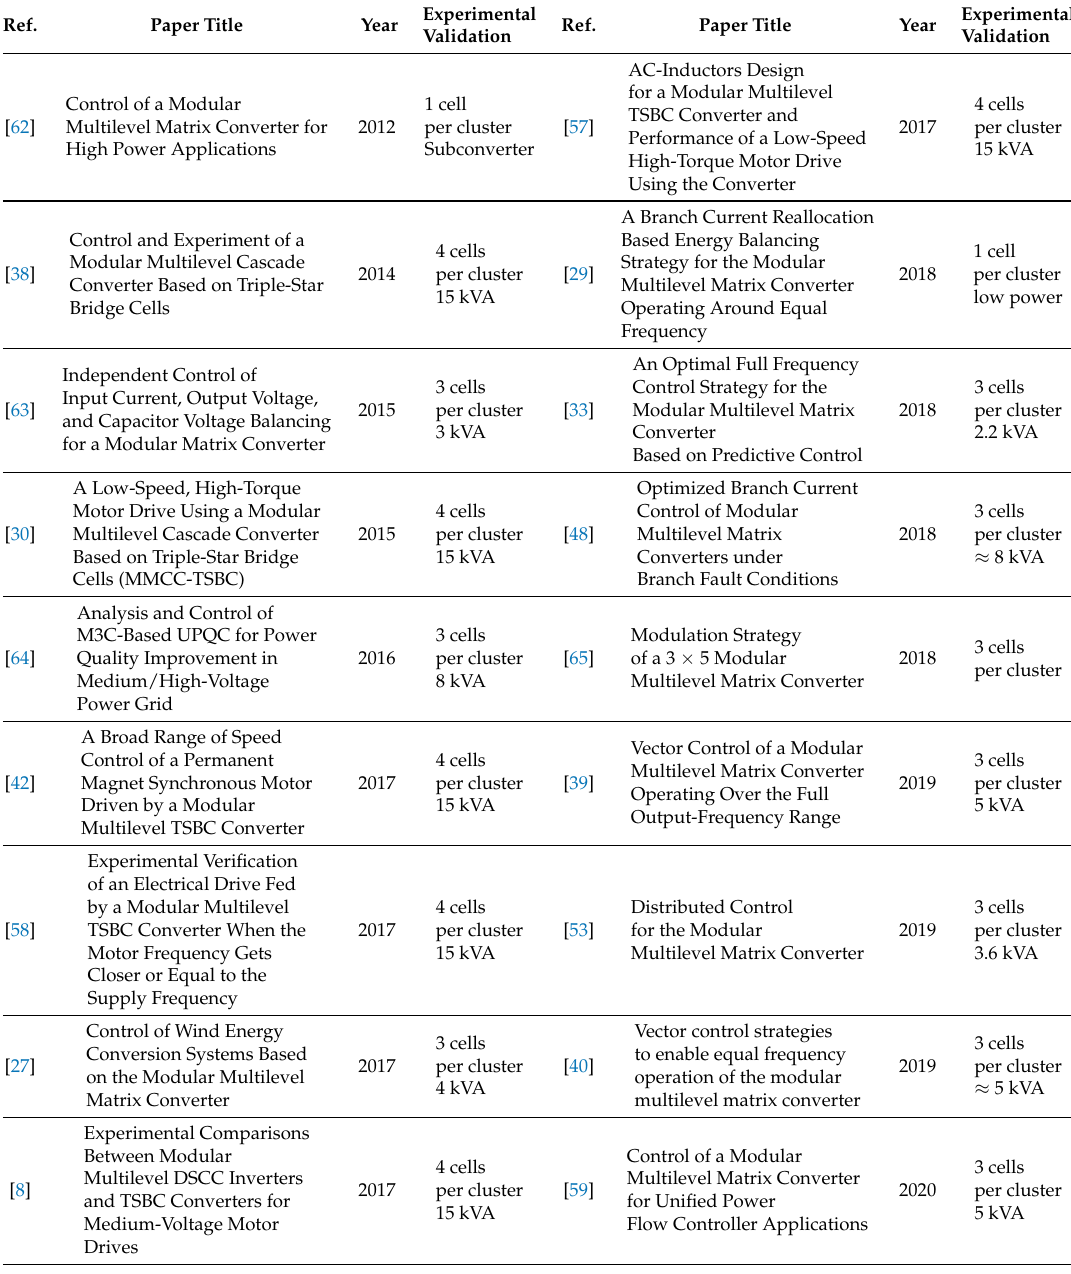
Table 1. Papers where experimental results are reported and discussed. Adapted from [28]. Ref.